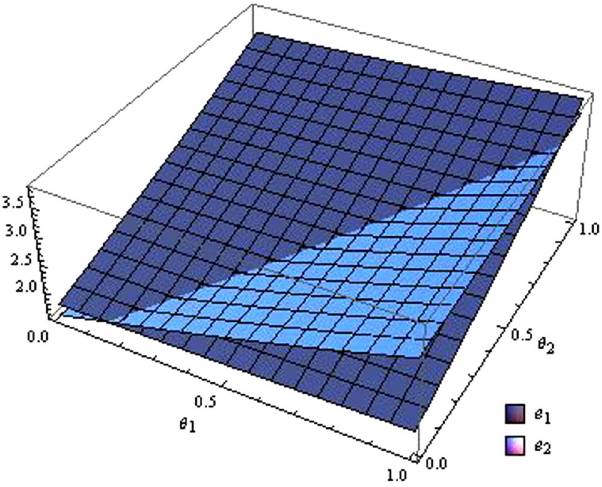
Figure 9. The impact of technological spillovers on carbon emissions reduction in the centralized